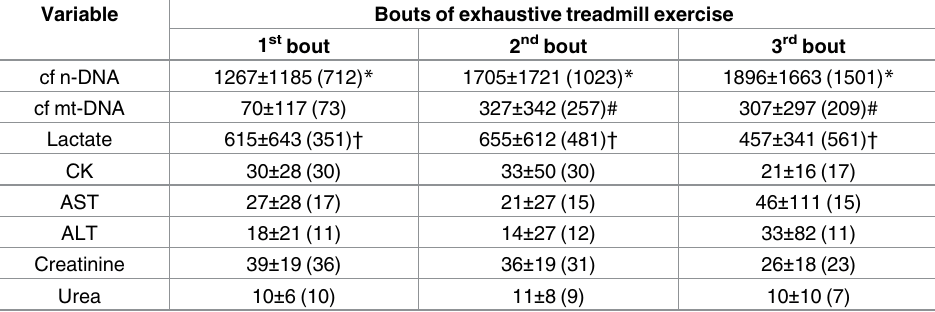
Table 5. Percentage increments in circulating cell free nuclear and mitochondrial DNA and selected metabolic and muscle damage markersin response to three repeated bouts of exhaustive treadmill exercisein healthy average-trained men.